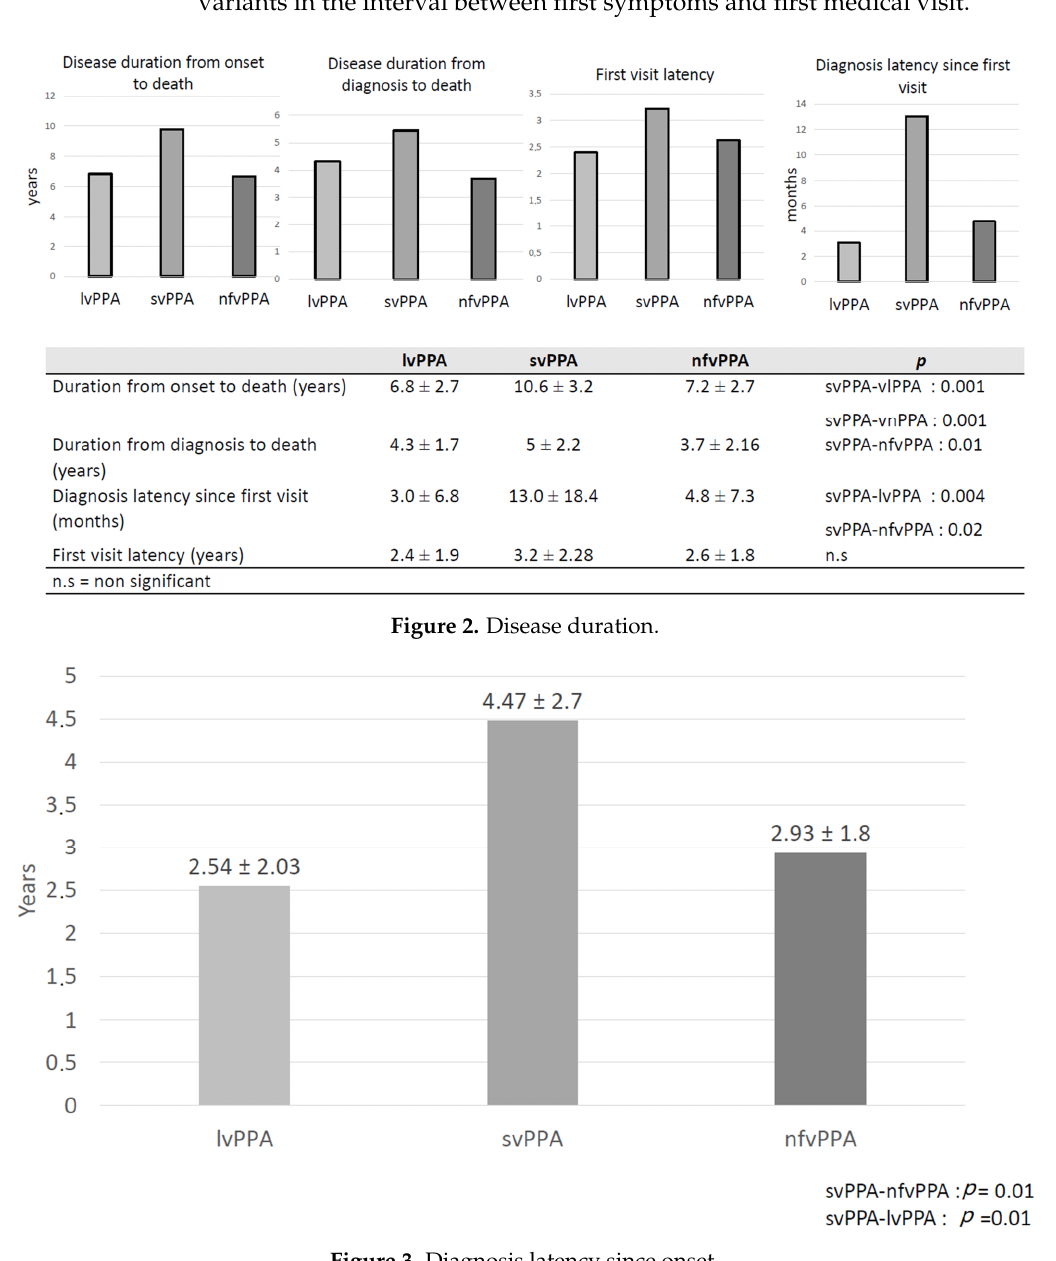
Figure 3. Diagnosis latency since onset.